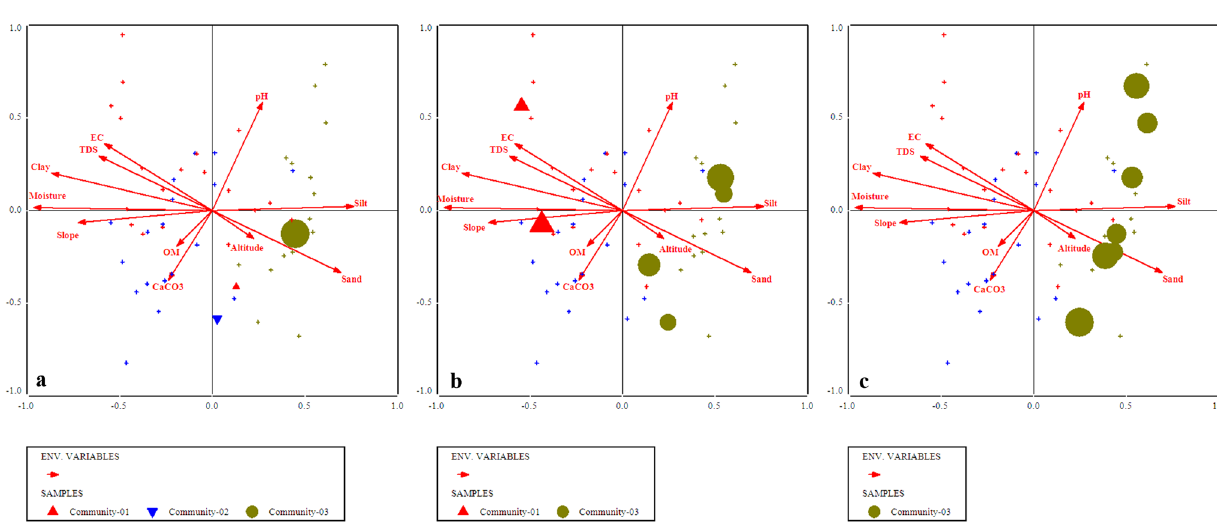
Figure 9. Indicator species biplots for ( a ) Taxus baccata, ( b ) Rubus ellipticus and ( c ) Potentella atrorubens top three indicators of 4th plants